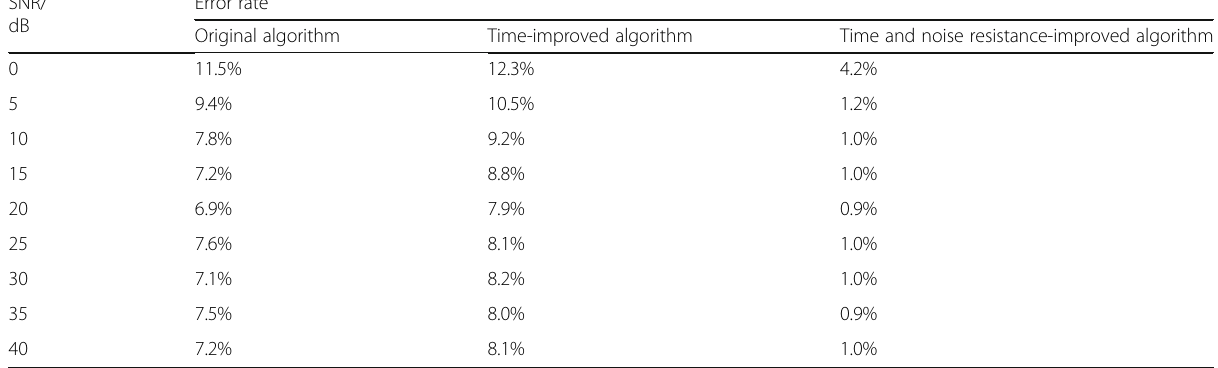
Table 1 Error rate comparison